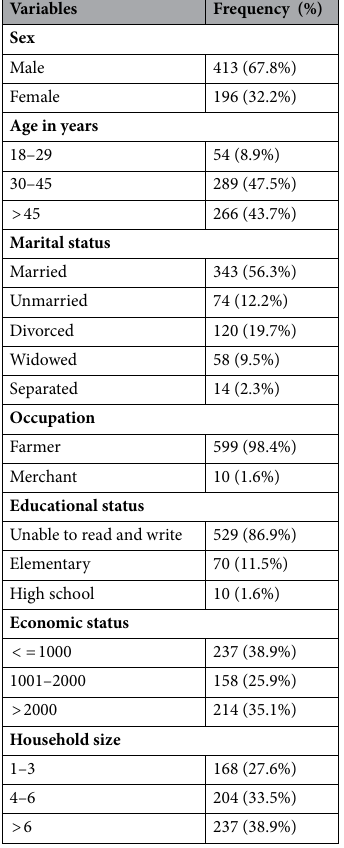
Table 1. Socio-demographic and economic factors of study